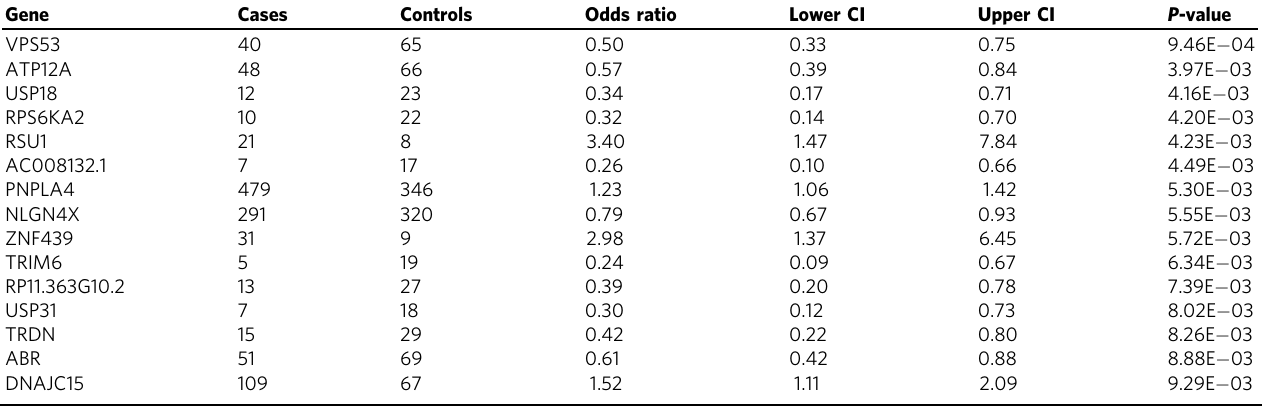
Table 5 Gene burden results for duplications. Gene